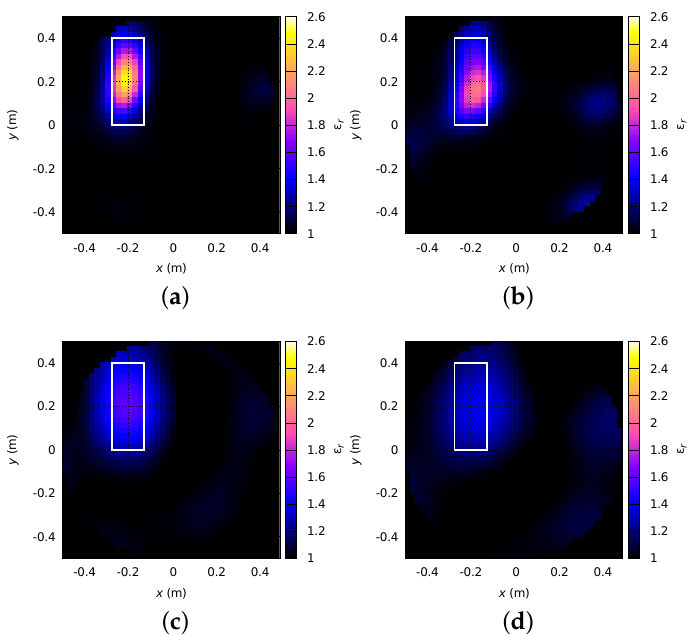
Figure 11. Rectangular cylinder. Examples of reconstructed distributions of the relative dielectric permittivity with enclosure of radius a = 2.125 λ and σ b = 2 mS/m. Upper row: L p -space results, with p = 1.2. ( a ) Reconstruction with cylindrical enclosure; ( b ) Reconstruction in free space. Lower row: Hilbert-space results. ( c ) Reconstruction with cylindrical enclosure; ( d ) Reconstruction in free